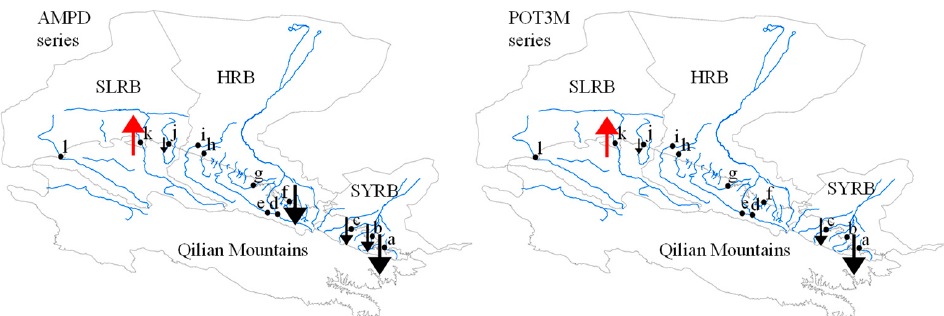
Figure 5. Trends in AMPD and POT3M flood series for 12 representative rivers in the QM region, northwest China. (a–c) Denote Gulang, Zamu, and Xiying rivers in SYRB, (d–i) denote Babao, Hei, Dazhuma, Liyuan, Hongshui, and Taolai rivers in HRB, (j–l) denote Shiyou, Shule, and Dang rivers in SLRB, respectively. A big arrow indicates a statistically increasing trend (red) and decreasing trend (black), at the significance level of 99%, a medium arrow indicates a statistically increasing trend (red) and decreasing trend (black), at the significance level of 95%, a small arrow indicates a statistically increasing trend (red) and decreasing trend (black), at the significance level of 90%. No marked symbol at stations represents a non-significant trend.